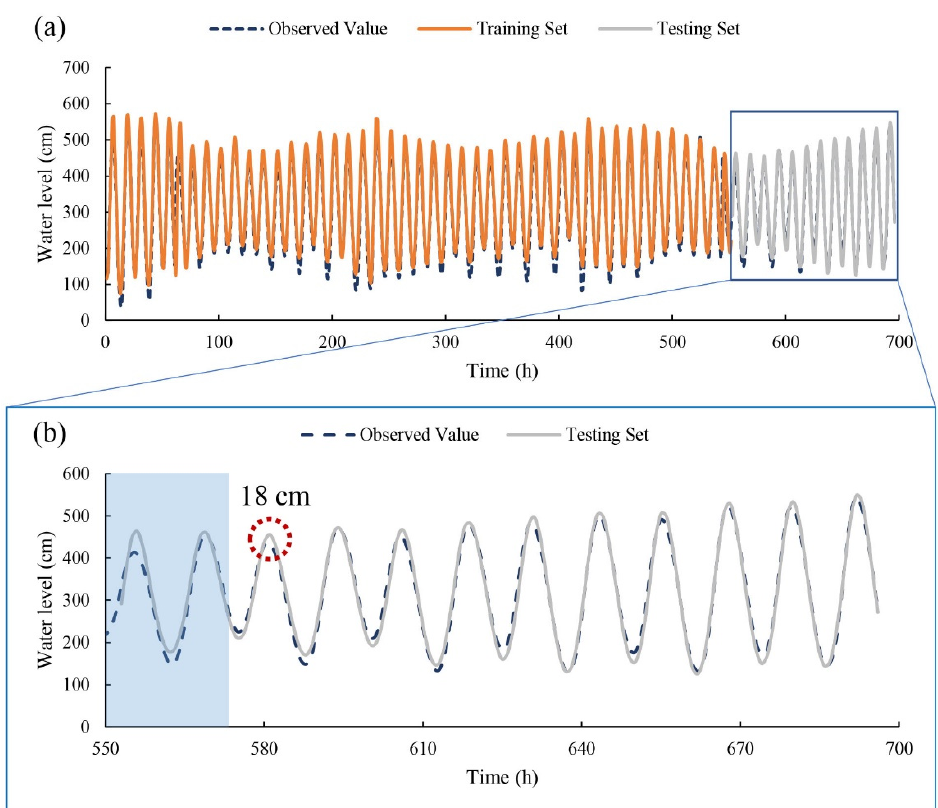
Figure 4. ( a ) Model results of the LSTM model with 1 h prediction time, and ( b ) the zoom-in view of the testing set section where the light blue area is the cold start subset. Red dash line circle represents the maximum difference between the modelled and observed values at the water level